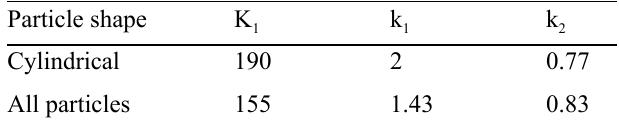
Table 2. Coefficients in equation (3) [10].